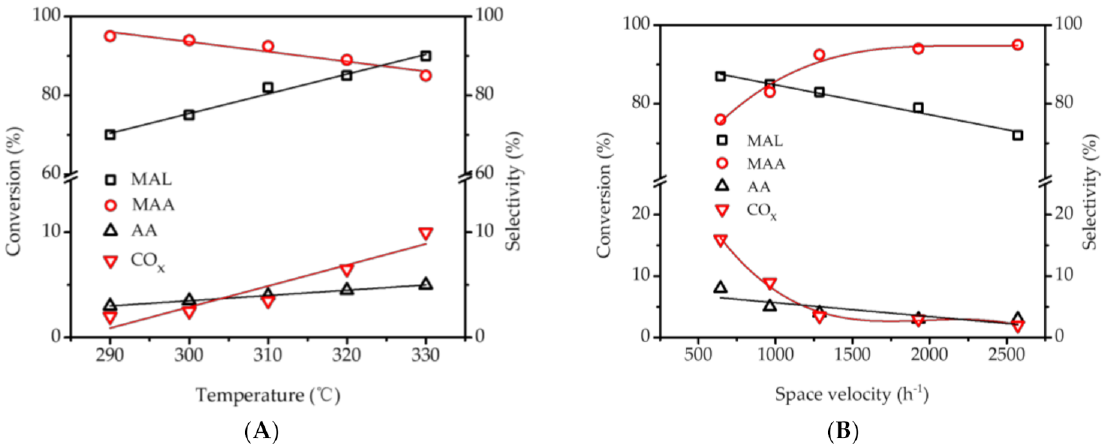
Figure 9. Catalytic performance with respect to the ( A ) temperature and ( B ) space velocity in K 0.6 CuCsNH 4 PVA. Reaction pressure, atmospheric pressure; catalyst, 6.001 g, 5 mL; reactor inlet composition: 3.3% v/v MAL, 9.3% v/v O 2 , 17.4% v/v H 2 O and N 2